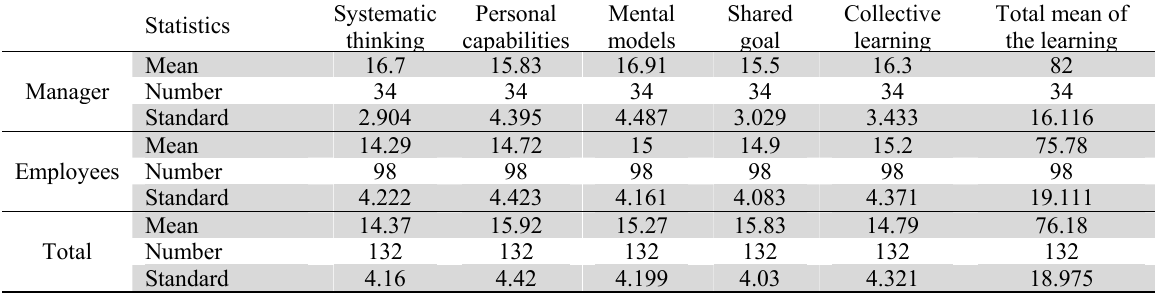
The results of mean and standard deviation of two groups for five scale